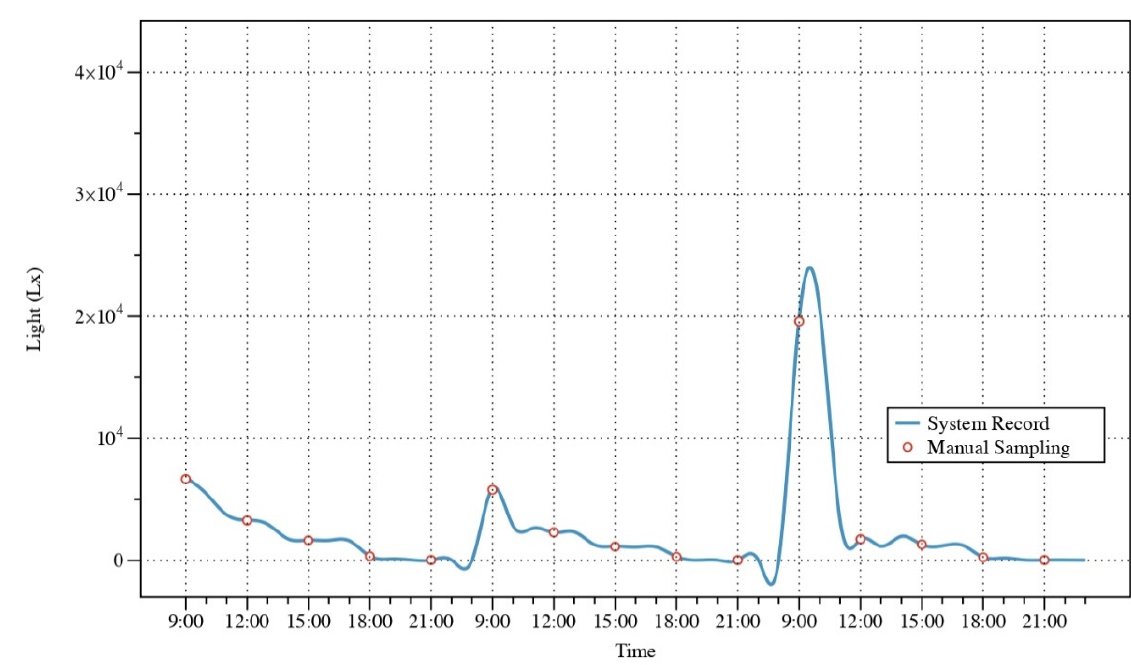
15 of 19 Figure 14. System record value and manual sampling of DO. Table 4. Comparison of the results of DO value. FN